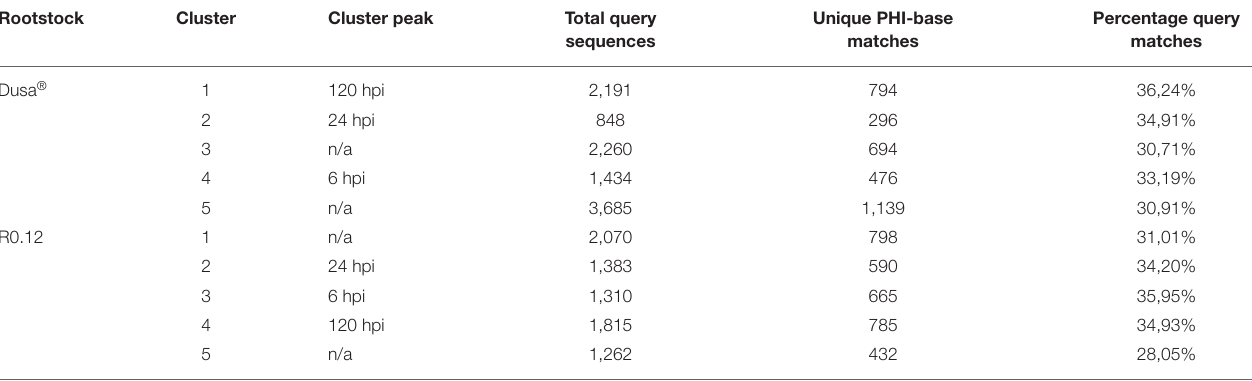
TABLE 1 | Summary statistics following comparison of temporal cluster member protein sequences to the Pathogen Host Interactions (PHI) database. Rootstock Cluster Unique PHI-base